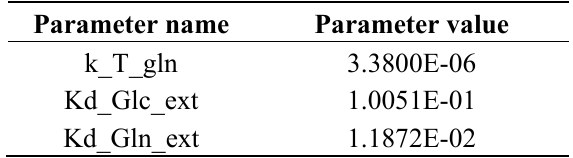
Table A4. Cell dynamics model parameter